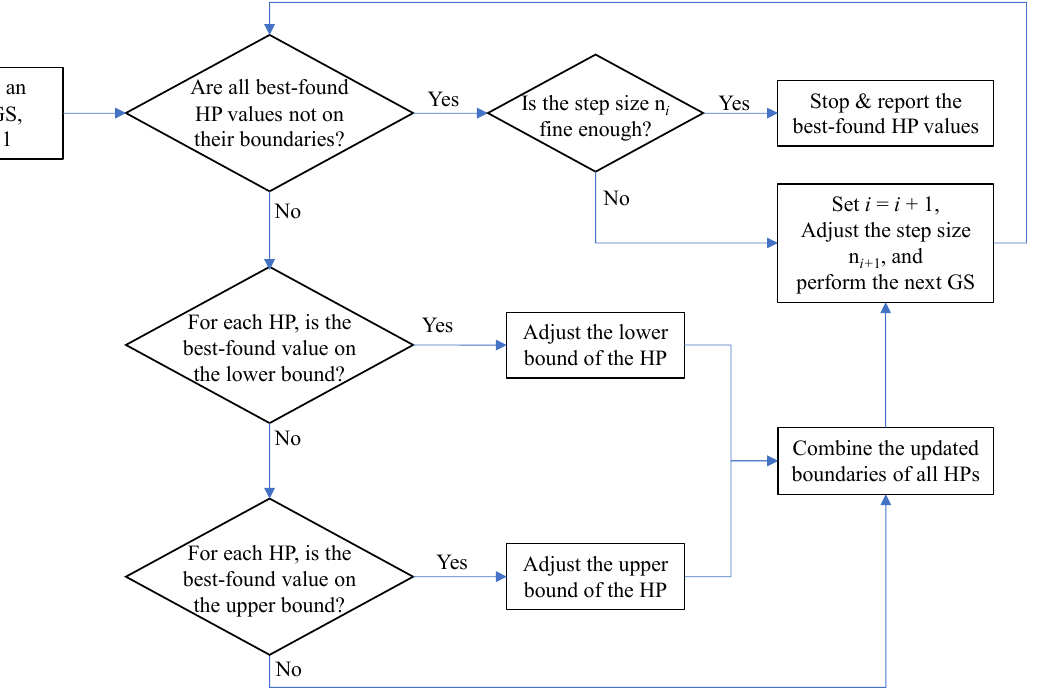
Figure 4. Sequential Grid Search for Hyperparameter Tuning of ML model.